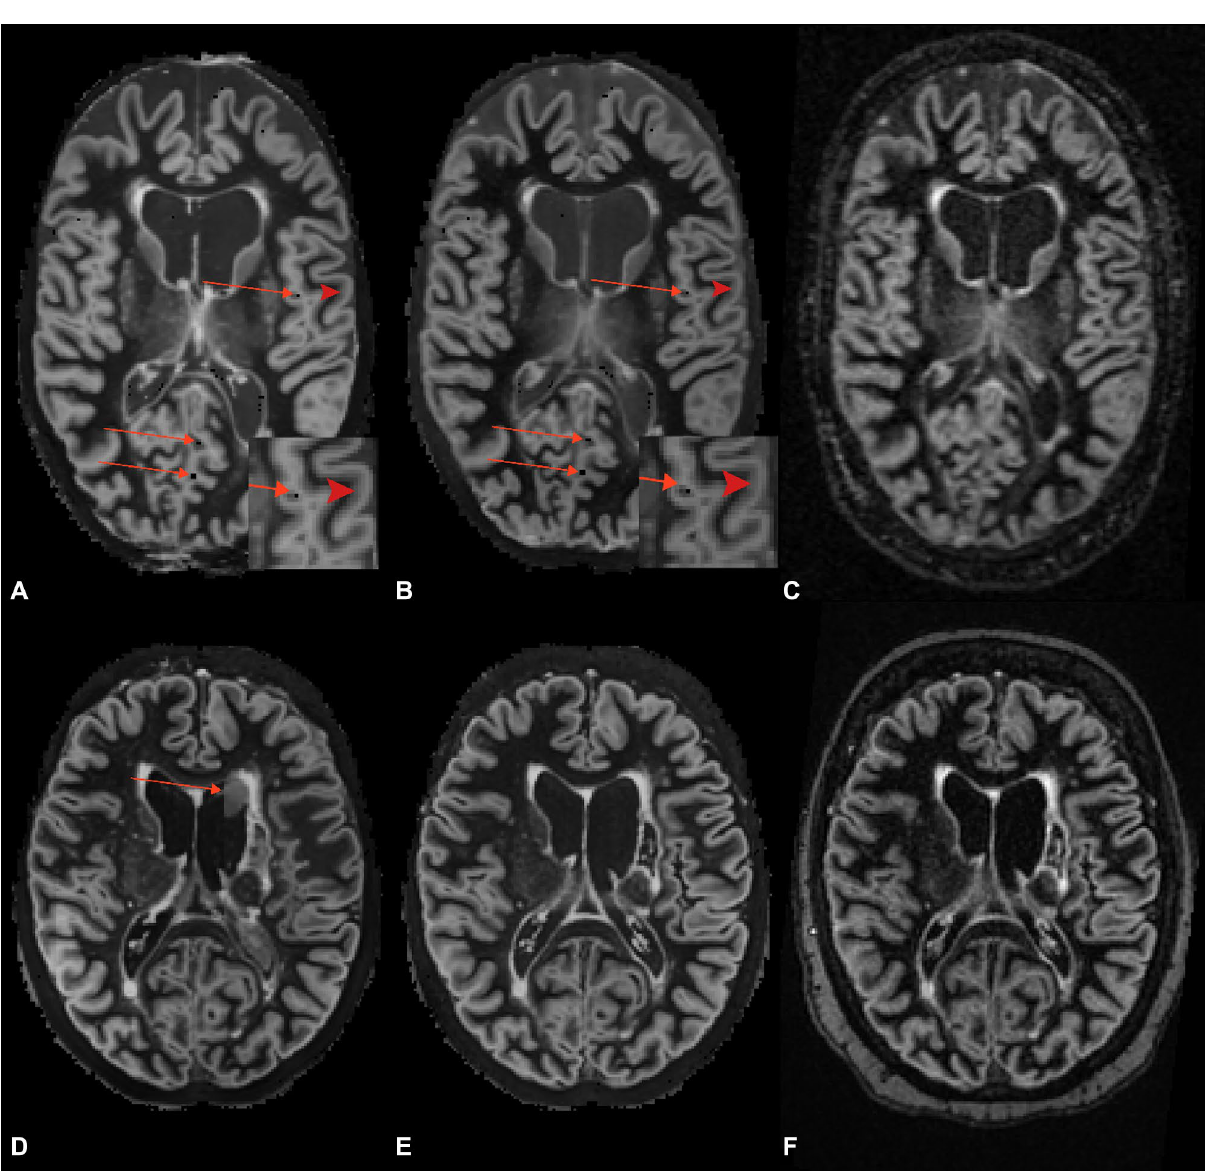
Figure 4. Artefacts in artificially generated images. ( A ) Artificial double inversion recovery (DIR) image generated from 3D-T 1 and PD/T 2 in which the arrows indicate ‘point artefacts’ and the chevrons indicate ‘rim artefacts’ in the cortex, which are also visible on artificial DIR images generated from 3D-T 1 and fluid- attenuated inversion recovery (FLAIR). ( C ) Conventionally acquired counterpart of the artificially generated images in ( A ) and ( B ). ( D ) ‘Patch artefact’ in artificial DIR image generated from 3D-T 1 and PD/T 2 , indicated by the arrows. ( E ) Corresponding artificial DIR generated from 3D-T 1 and FLAIR and ( F ) corresponding conventionally acquired DIR (generated using Adobe Illustrator—Adobe Inc., 2019. Adobe Illustrator, Available at https:// adobe. com/ produ cts/ illus